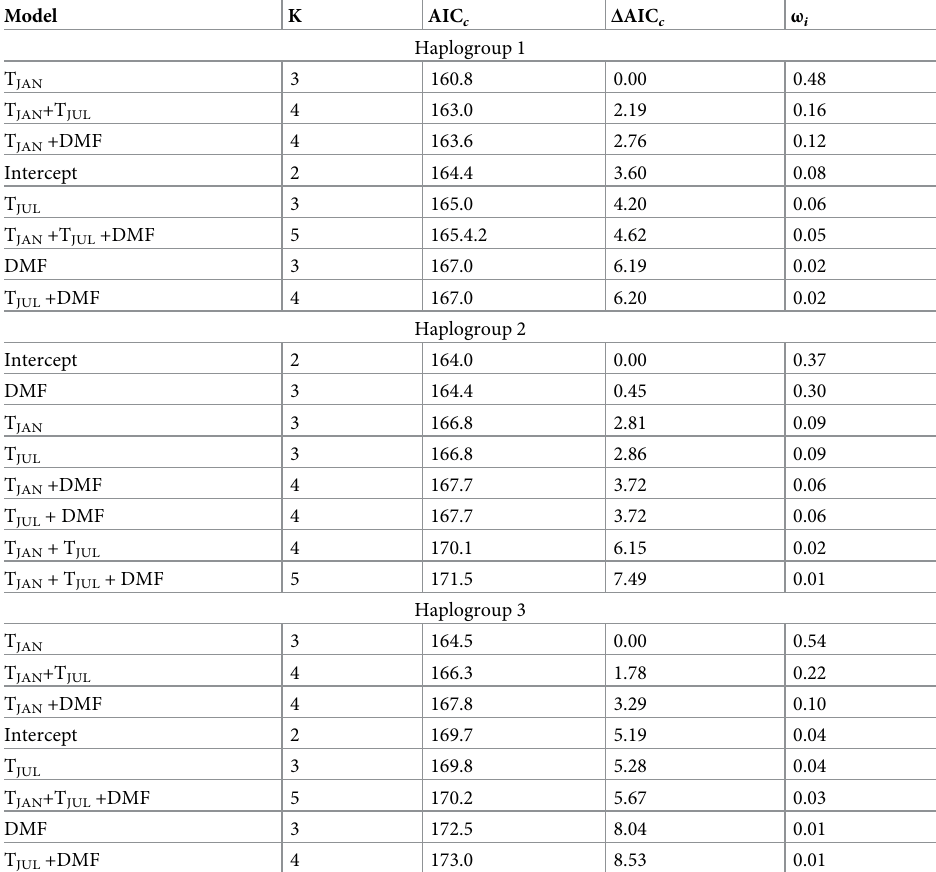
Table 3. Model selection (based on the AICc criteria) for the considered GLMMs which aimed at assessing the effect of mean temperature of January (T JAN ), mean temperature of July (T JUL ) and percentage cover of decid- uous-mixed forests (DMF) on the probability of haplotype assignment to Haplogroups 1, 2 and 3.